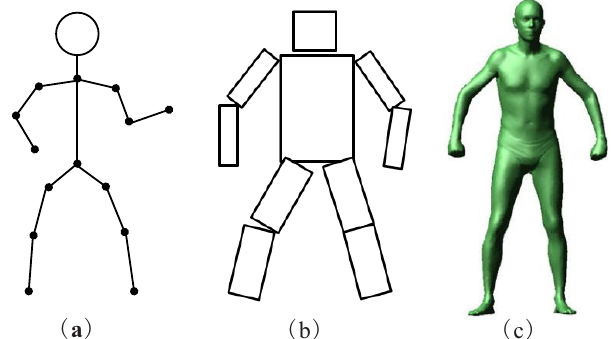
Figure 10. Three Types of Human Body Models. ( a ) Kinematic model; ( b ) Cardboard model; ( c ) Volumetric